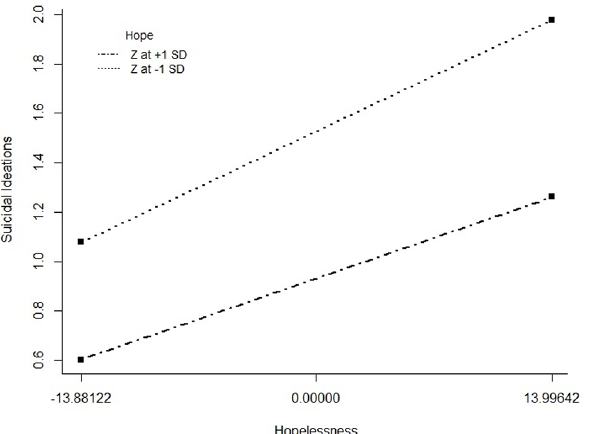
Fig 3. Interaction Plot of Hope Moderating Hopelessness in Predicting Suicidal Ideation. Level of hope (as measured by the Hope Scale) moderates the relationship between hopelessness (as measured by the Beck Hopelessness Scale) and suicidal ideation (as measured by the Adult Suicidal Ideation Questionnaire). For individuals high on hope (scoring one standard deviation above the mean on the Hope Scale), there is smaller increase in suicidal ideation at higher levels of hopelessness than individuals low on hope (scoring one standard deviation below the mean on the Hope Scale).